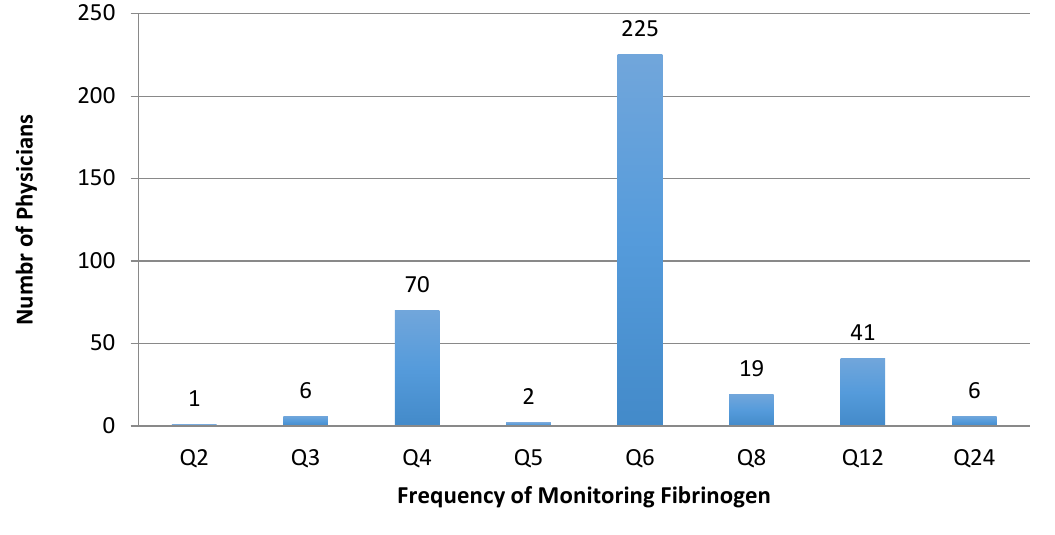
Figure 3. Frequency (in hours) with which plasma fibrinogen levels are monitored in those who routinely monitor during thrombolysis procedures. Q2 = every 2 h, Q3 = every 3 h, Q4 = every 4 h, Q5 = every 5 h, Q6 = every 6 h, Q8 = every 8 h, Q12 = every 12 h, Q24 = every 24 h. Adjustment of TPA dose based on fibrinogen levels was variable. Of those that monitored fibrinogen, 10 respondents (2.2%) did not decrease the TPA dose based on falling fibrinogen, but would give cryoprecipitate or fresh frozen plasma (FFP). In the remaining respondents who did adjust TPA based on fibrinogen levels ( n = 364), the threshold fibrinogen level that prompted TPA adjustment varied. The most common level at which TPA was held was at 100 mg/dL ( n = 143; 31.4%), with a range of 40 – 150 mg/dL. The most common fibrinogen level at which to decrease the dose of TPA was 150 mg/dL ( n = 105; 23.1%), with a range of 40 – 300 mg/dL. Twenty-four practitioners (5.3%) decreased the TPA dose based on a percentage drop from the baseline, rather than an absolute value. Once TPA was held, there was variability in the protocol for rechecking